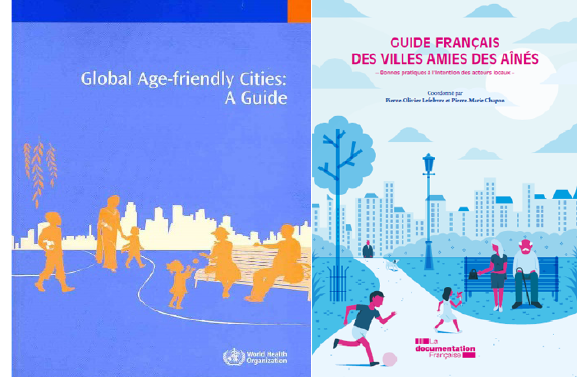
Figure 1. Cover to Global Age-Friendly Cities: A Guide (WHO, 2007a) and Cover to the Guide Français VADA (Lefebvre & Chapon, 2014).